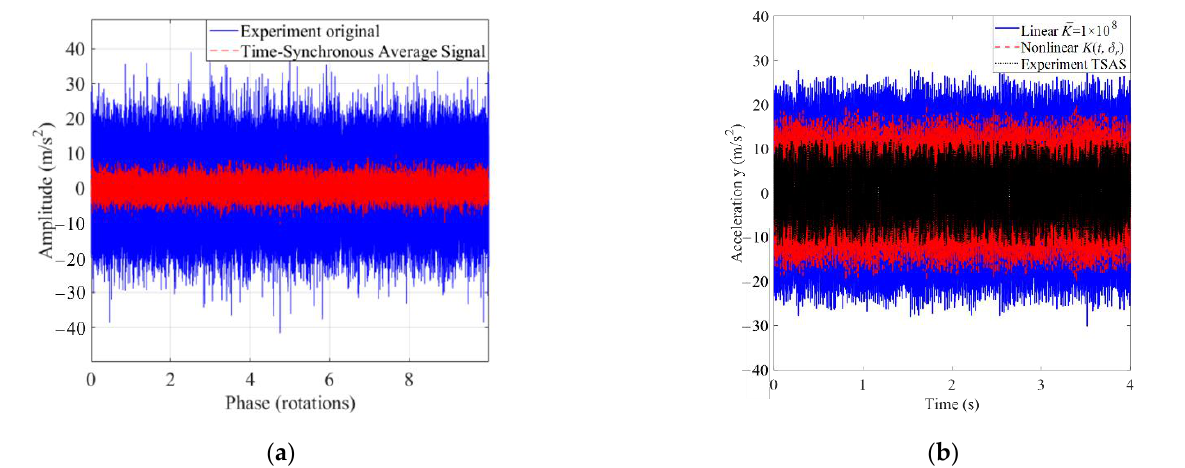
Figure 12. Dynamic responses of sun gear with 700 rpm-200 N · m: ( a ) experimental data and its time-synchronous average signal; ( b ) experimental data and simulation data (note: TSAS means the Time-Synchronous Average Signal).